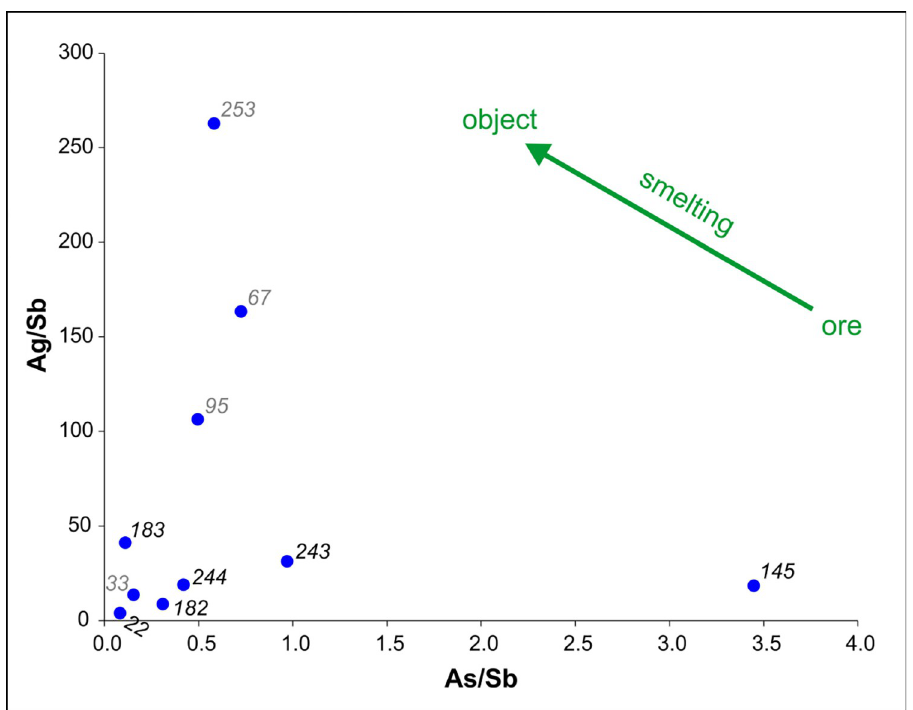
Fig 19. The silver/antimony (Ag/Sb) ratio versus the arsenic/antimony (As/Sb) ratio.